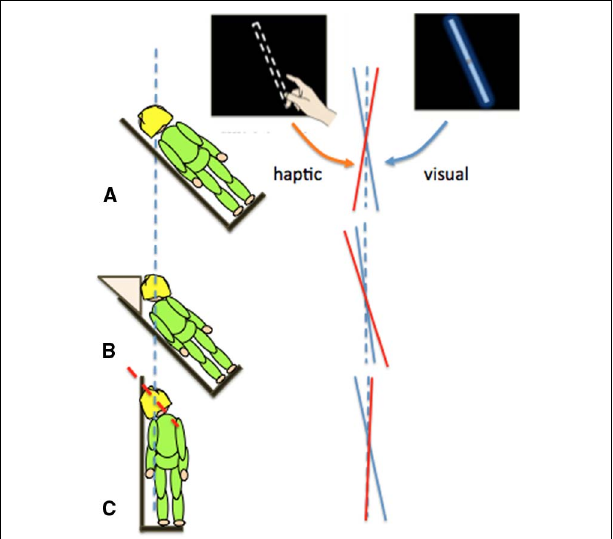
FIGURE 2 | Different errors in the judgment of gravity vertical in the visual (blue lines) or haptic (red lines) modalities when participants had their whole body (A) or just their torso (B) or head (C) rolled by